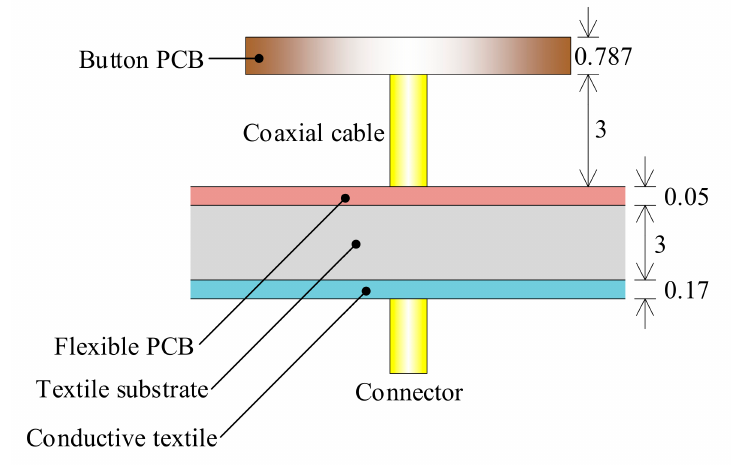
Figure 5. Side view of the proposed antenna sensor. Dimensions are in